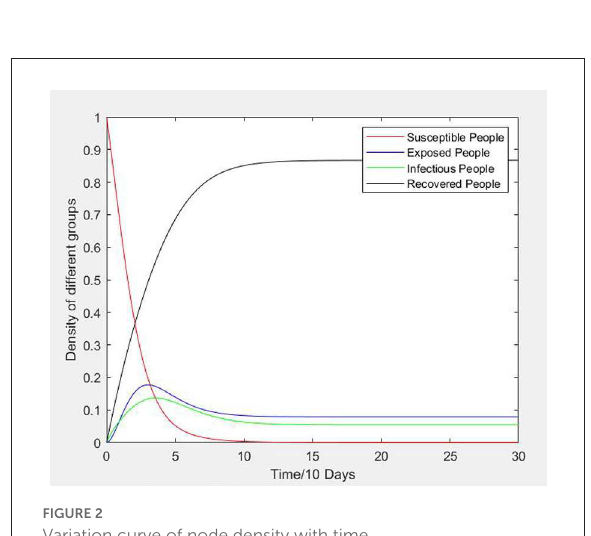
FIGURE2 Variation curve of node density with